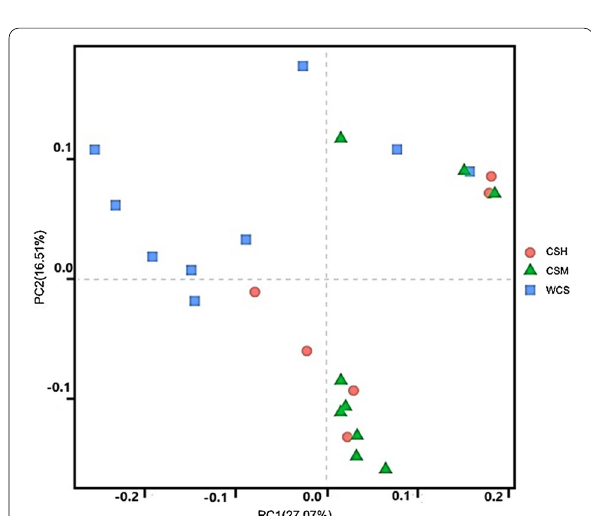
Fig. 1 Principal coordinates analysis (PCoA) of microbial diversity across all samples using a unweighted UniFrac metric. The percentage of variation explained by PC1 and PC2 are indicated in the axis. CSH, cottonseed hull; CSM, cottonseed meal; WCS,